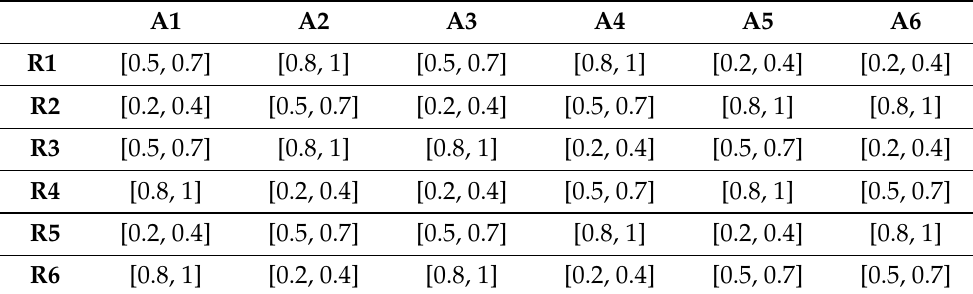
Table 3. Survival time payoffs for the defender in Case Study-2.